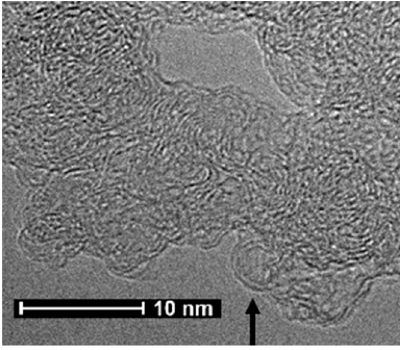
Figure 13. TEM micrograph of sucrose char after 1 s at 2600 °C.